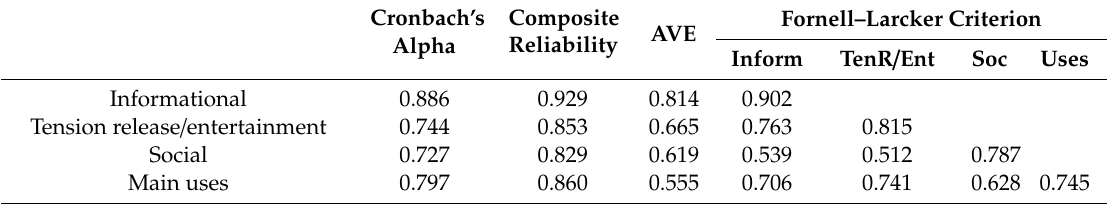
Table 3. Internal consistency, convergent and discriminant validity of the measurement